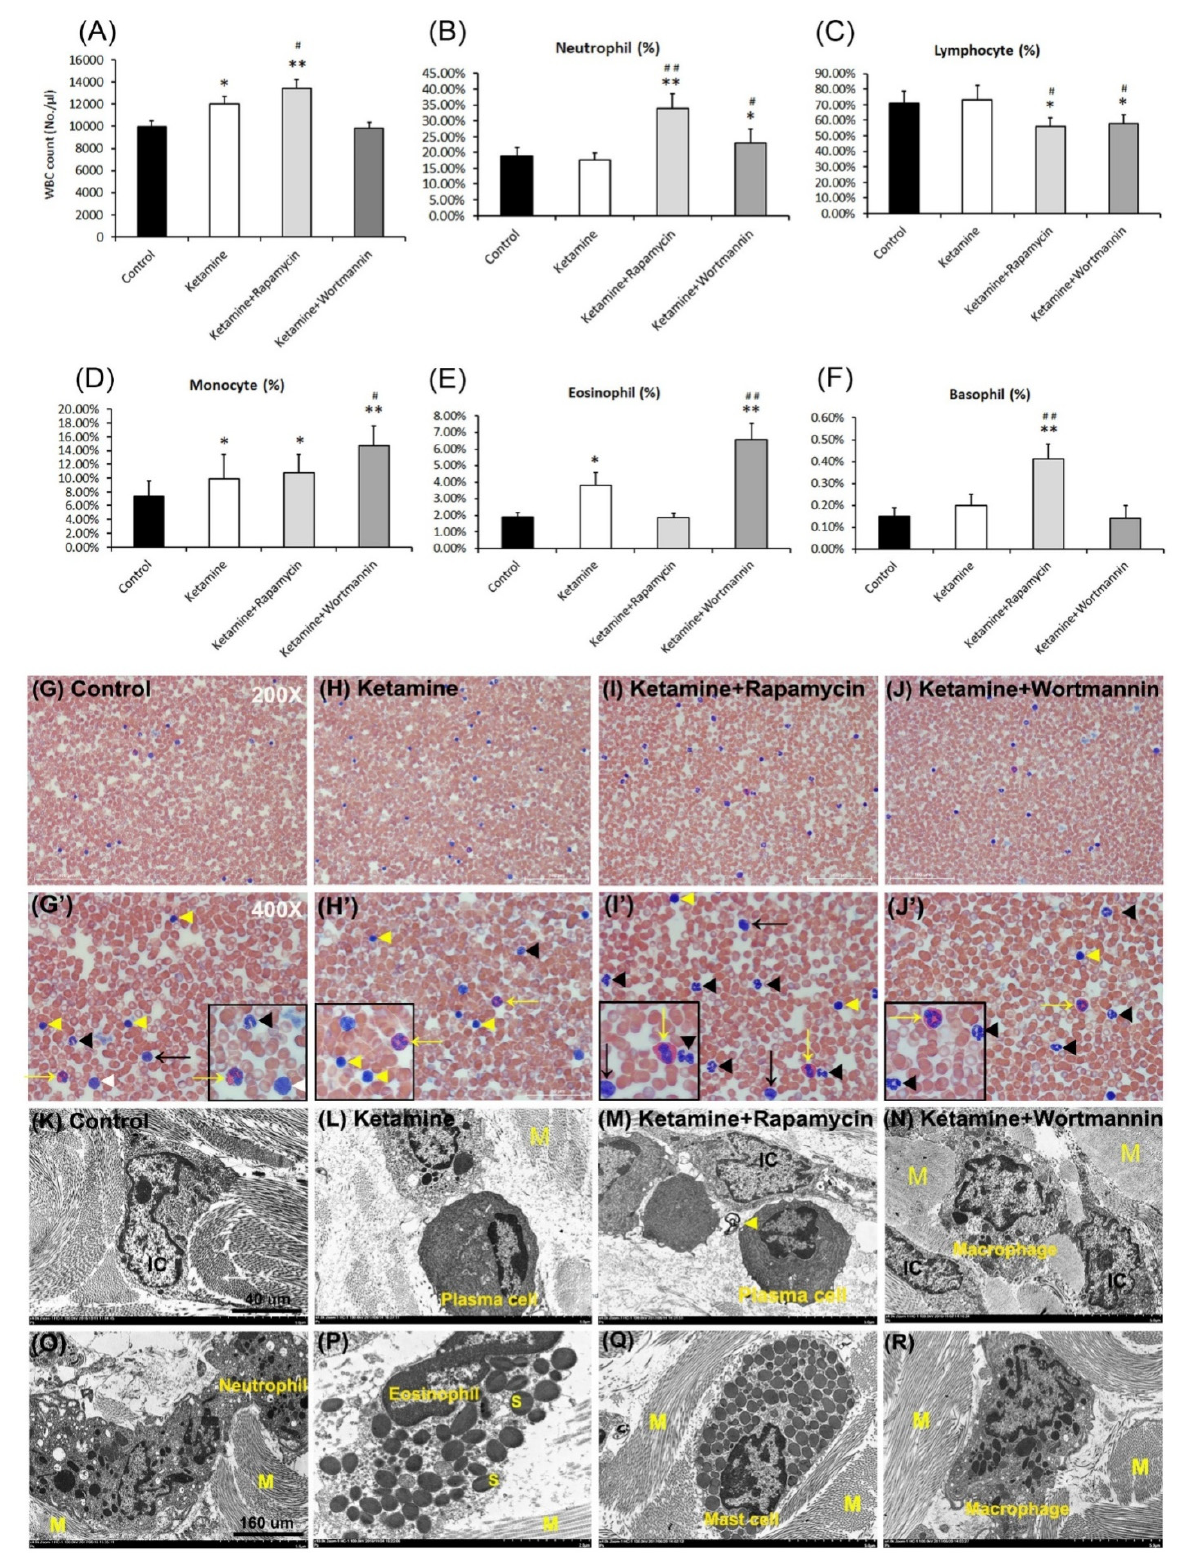
Figure 5. Significant changes in the numbers of total white blood cells (WBCs) and leukocyte differential counts. Quantifica- tion of the number of total WBCs was shown in ( A ). Quantifications for the percentage (%) of circulating neutrophils ( B ), lymphocytes ( C ), monocytes ( D ), eosinophils ( E ), and basophils ( F ) to total WBCs were present. Treatment with ra- pamycin alleviated eosinophil-mediated inflammation to improve the pathogenesis of KIC. Data are presented as means ± SD, * p < 0.05, ** p < 0.01 versus control group; # p < 0.05, ## p < 0.01 versus ketamine group. ( G – J and G’ – J’ ) The prominent